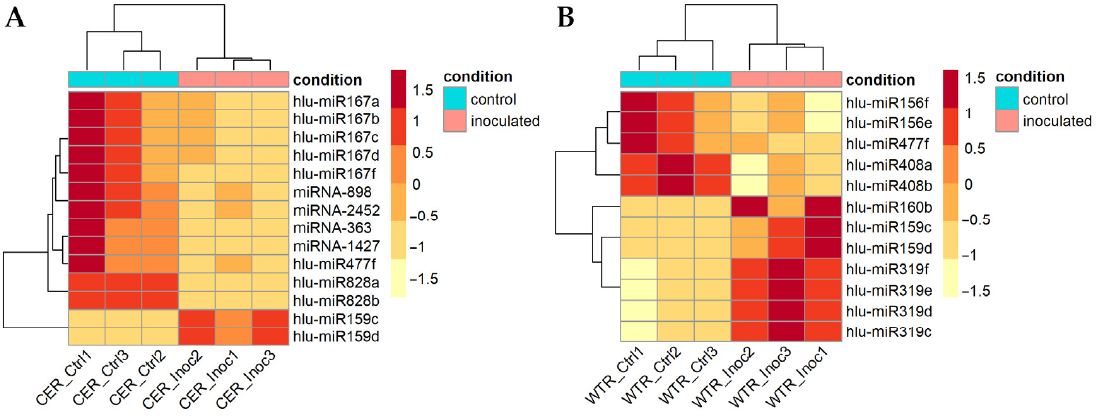
Figure 2. Heat map of differentially expressed miRNAs between V. nonalfalfae -inoculated (Inoc) and control (Ctrl) root samples (three biological replicates) of ( A ) the susceptible cultivar Celeia (CER) and ( B ) the resistant cultivar Wye Target (WTR). The colour scale represents the z-score scaled by row of the normalized read counts. Clustering was performed using the Euclidean distance measure and complete clustering method.